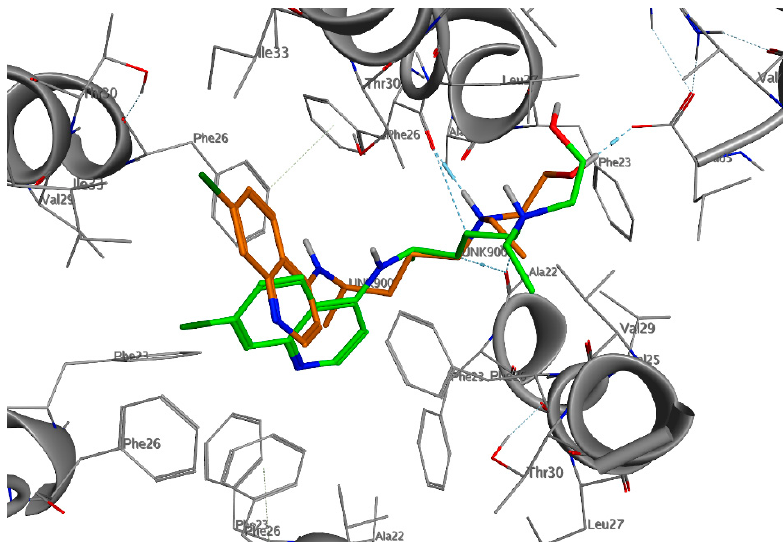
Figure 2. Three-dimensional (3D)-interaction diagram of HCQ in the docked pose (green) and average pose during molecular dynamics (MD) simulation (orange) with the E protein.